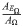
The rates of AEΩAΩ (blue points) and AEΦAΦ (red points) with the mask of randomly 925 unknown region.The average rate of the 237 images is 0.116 for the blue points and 0.095 for the red points.